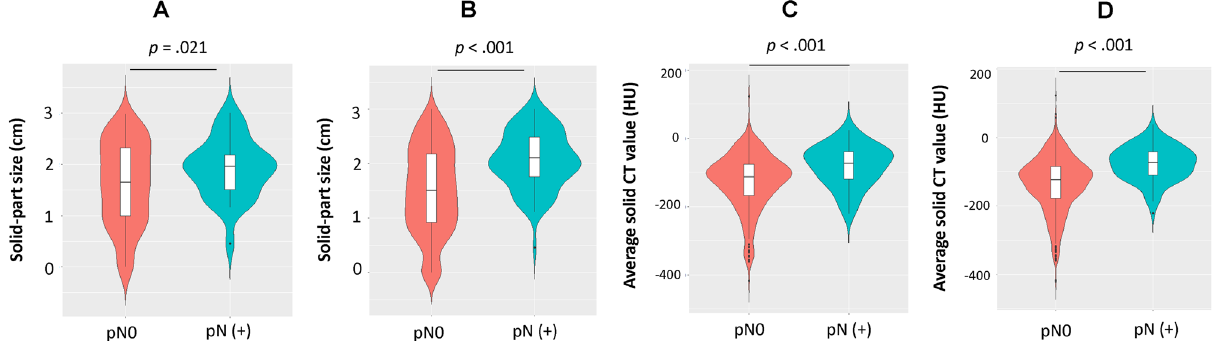
Figure 4. Violin plots for the comparison of the distribution of solid-part size in the validation cohort ( A ) and entire cohort ( B ), and average solid CT value in the artificial intelligence in the validation cohort ( C ) and entire cohort ( D ). pN( +)—pathological lymph node positive; CT—computed tomography; HU—Hounsfield